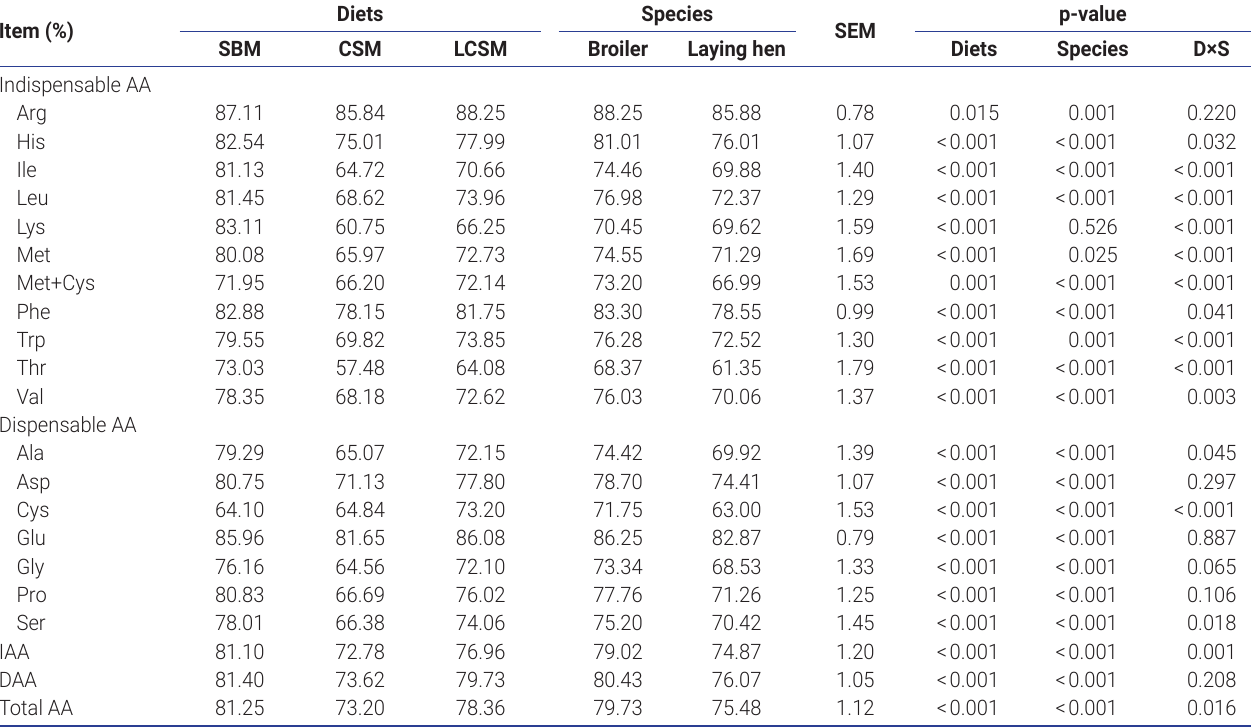
Table 5. Comparison of apparent ileal digestibility of AA between broilers and laying hens fed different ingredient